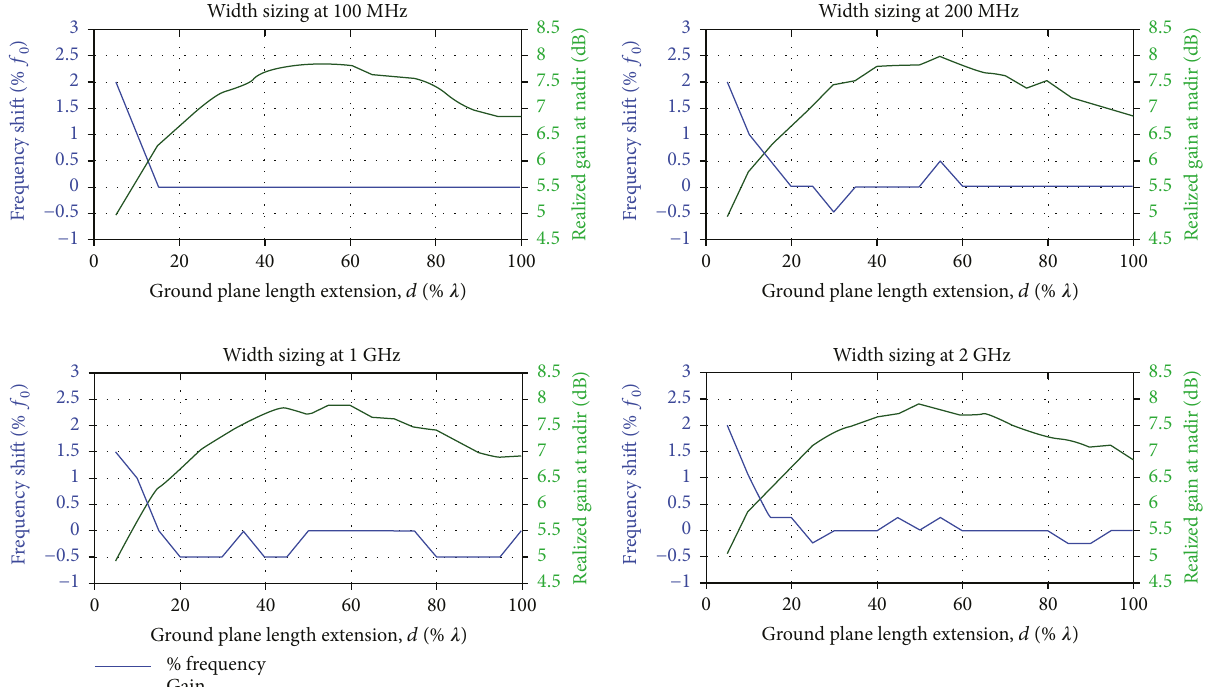
Figure 11: Ground plane width extension versus frequency shift and realized gain at nadir plot for all operating